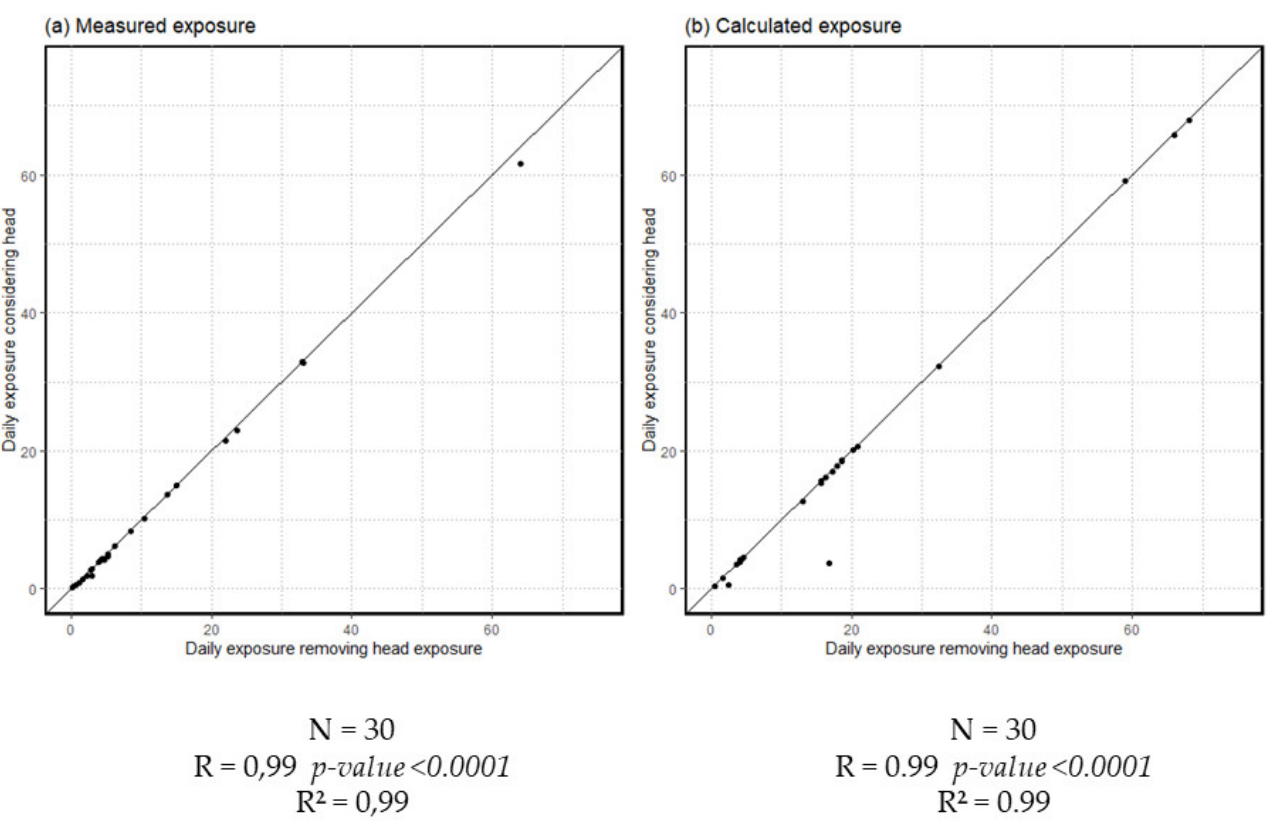
Figure A4. Linear regression of daily exposure (mg): calculated using the AOEM and measured in the CANEPA study.